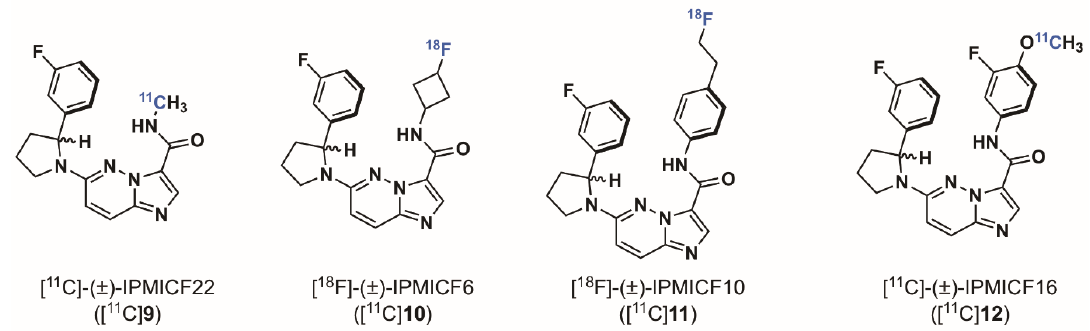
Pharmaceuticals 2018 , 11 , x FOR PEER REVIEW Figure 5. Chemical structures of preclinical imidazo[1,2 b ]pyridazine-based Trk-targeted PET radioligands.